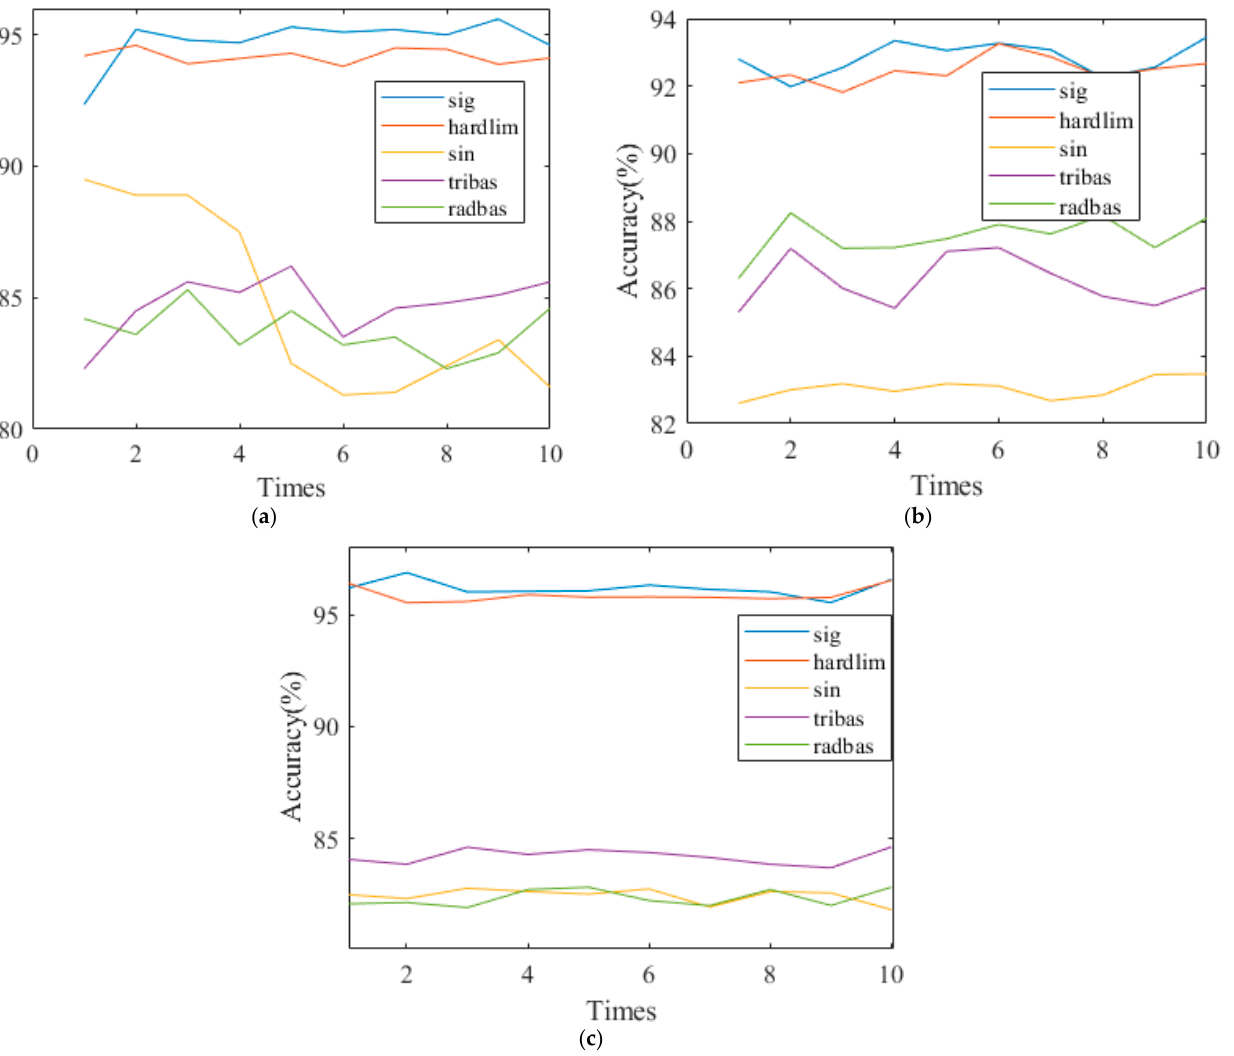
Figure 8. Select activation function of the ILSTM-BRVFL: ( a ) calculation results of w 1 ; ( b ) calculation results of w 2 ; ( c ) calculation results of w 3 .